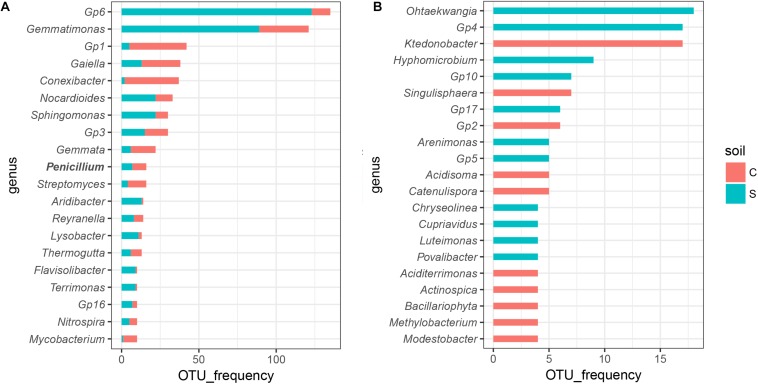
Sensitive OTUs that responded to invading Fusarium varied by soil suppression status. Significantly altered (PFriedman’s test < 0.05) OTUs in at least one time point in the disease-suppressive and disease-conducive soils classified to the genus level. Bar plots show the top 20 (A) shared genera and those that were (B) unique to one soil.